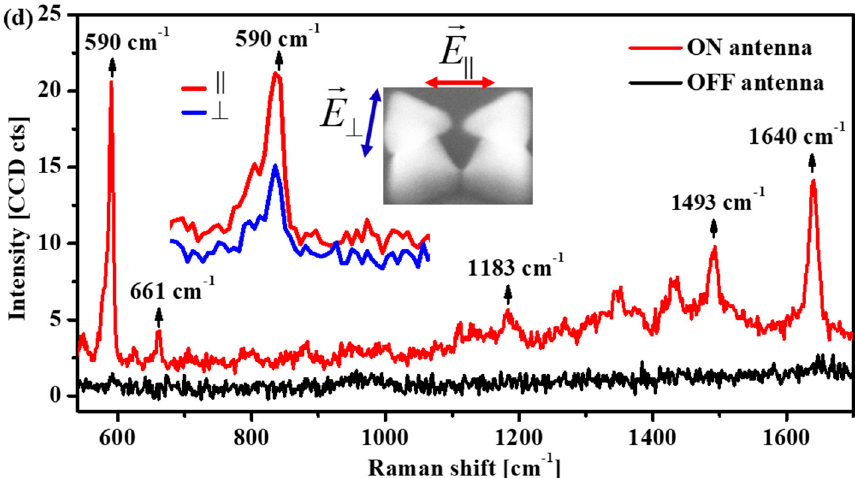
Figure 3. Demonstration of the electromagnetic field enhancement of free-standing bowtie antennas by SERS. ( a ) Optical image (seen under confocal microscope), ( b ) Raman mapping, and ( c ) corresponding plasmonic dark-field scattering mapping of the antenna arrays, respectively. The scale bar indicates 2 µ m in all ( a ), ( b ), and ( c ). ( d ) SERS measurements of the Nile-blue molecules on the Al bowtie antennas. The black curve and red curve show Raman signals “OFF” and “ON” the antennas. The small inset indicates the Raman signals under di ff erent excitation conditions; with polarization parallel to the bowtie axis (red) and perpendicular to the bowtie axis (black),